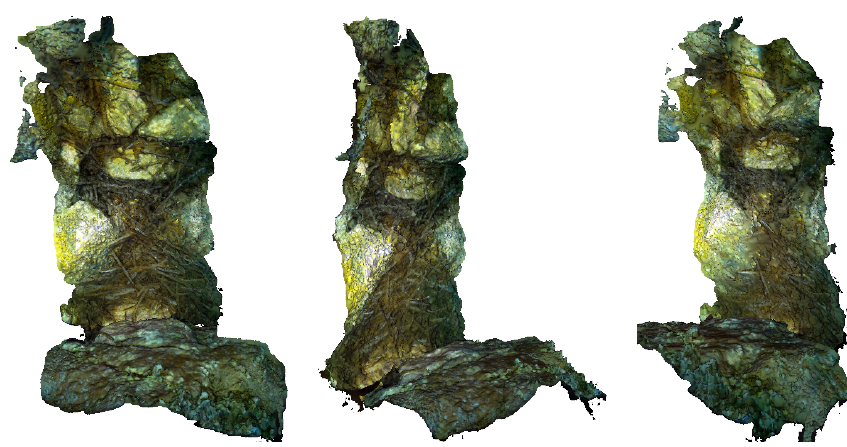
Figure 12. 3D reconstructed models using images captured with the handheld system.